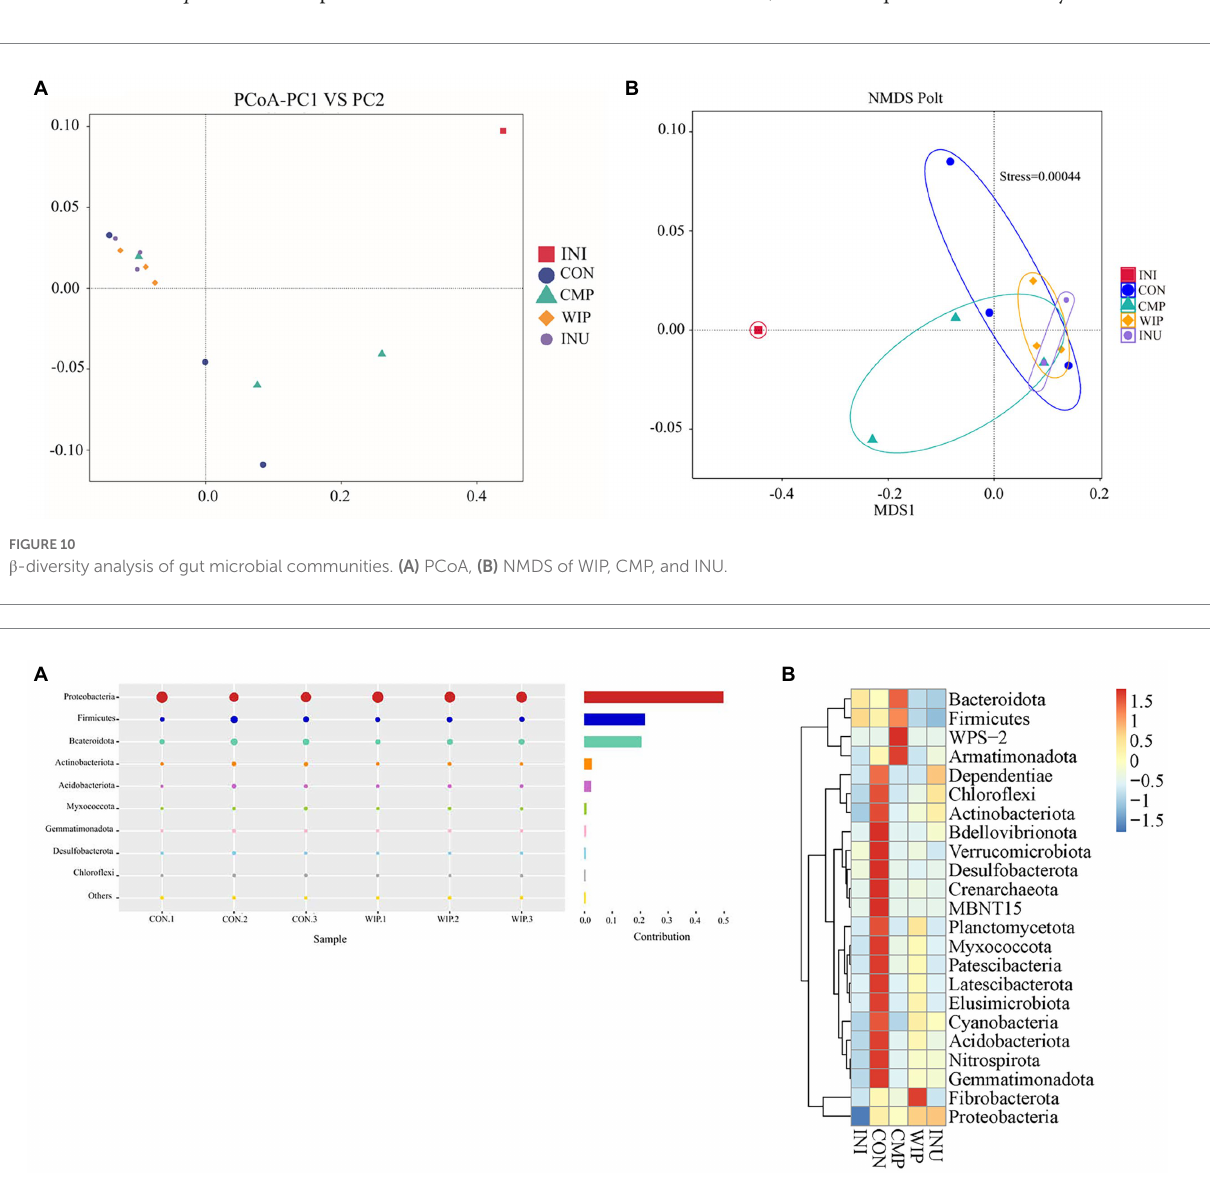
FIGURE 11 Contribution of species on gut microbial communities. (A) Simper analysis of WIP, (B) Heatmap analysis of WIP, CMP, and INU at the phylum level.